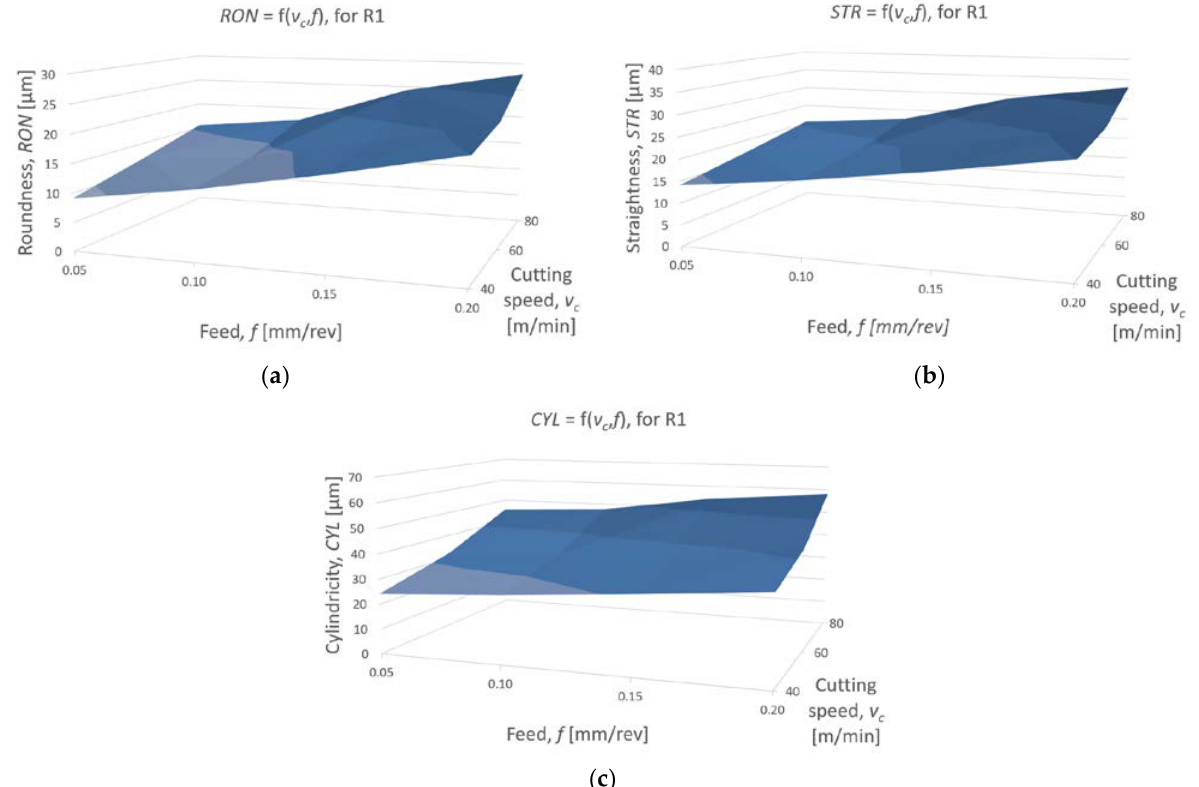
Figure 16. ( a ) Roundness, ( b ) straightness and ( c ) cylindricity as a function of the cutting parameters ( f , v c ), for R1.